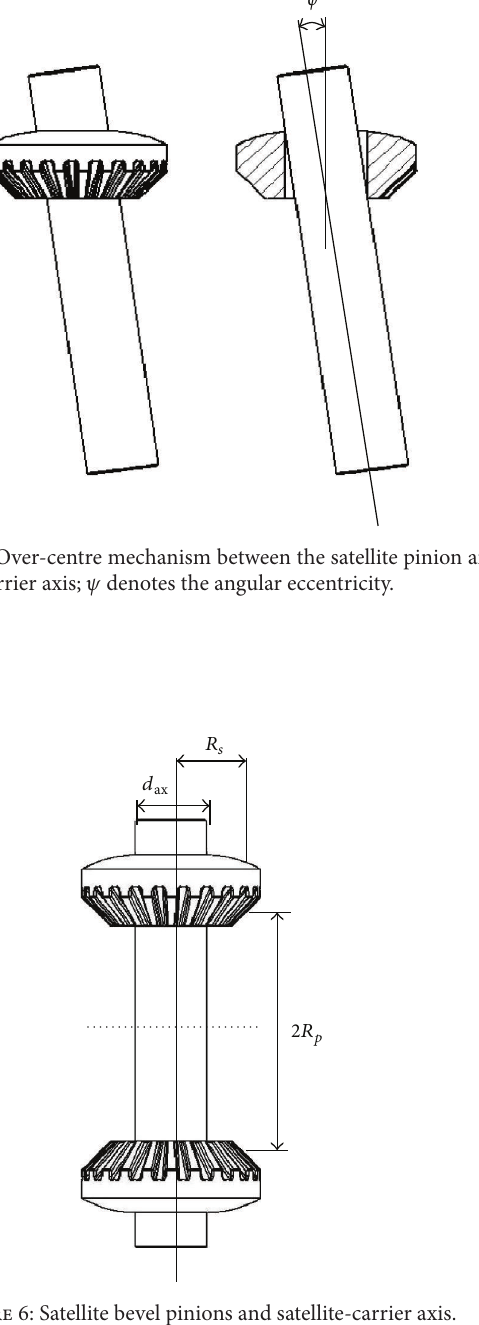
where 𝐹 𝑡 𝑗 , 𝐹 𝑟 𝑗 , and 𝐹 𝑎 𝑗 (with 𝑗 = lw , rw) are the tangential, radial, and axial forces of 𝑗 -planetary pinions (associated with the left and right wheels, Figure 7; see [19]), respectively, 𝑋 the resulting force applied to the satellite pinion generated by the plastic shell, 𝛿 is the half-angle pitch radius of the satellite pinion (see Figure 8(a)), and 𝛼 is the pressure angle between the satellite and planetary pinions, which is assumed here to be identical between the satellite/planetary meshing gears (see Figure 8(b)).